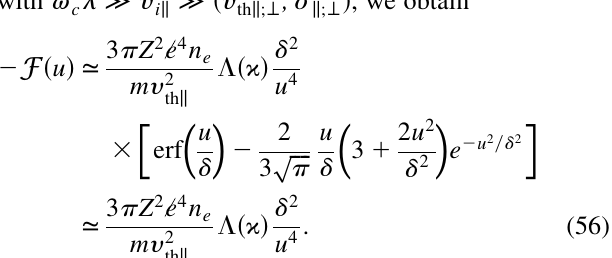
Fig. 8 (filled circles) for various fully stripped ions.